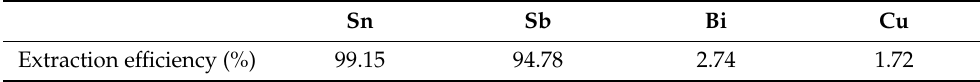
Table 3. Extraction efficiency of Sn, Sb, Bi, and Cu with TBP at optimal conditions.